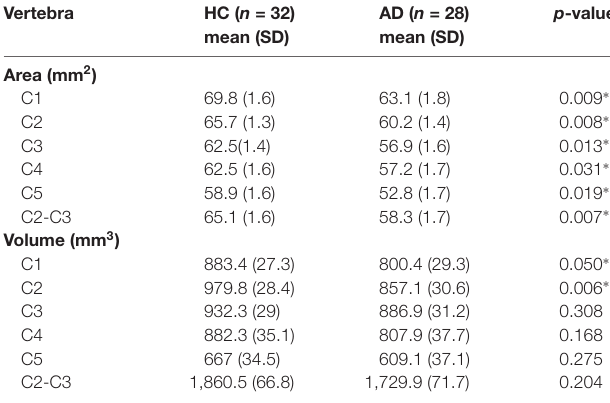
TABLE 3 | Spinal cord morphometric changes in AD patients.